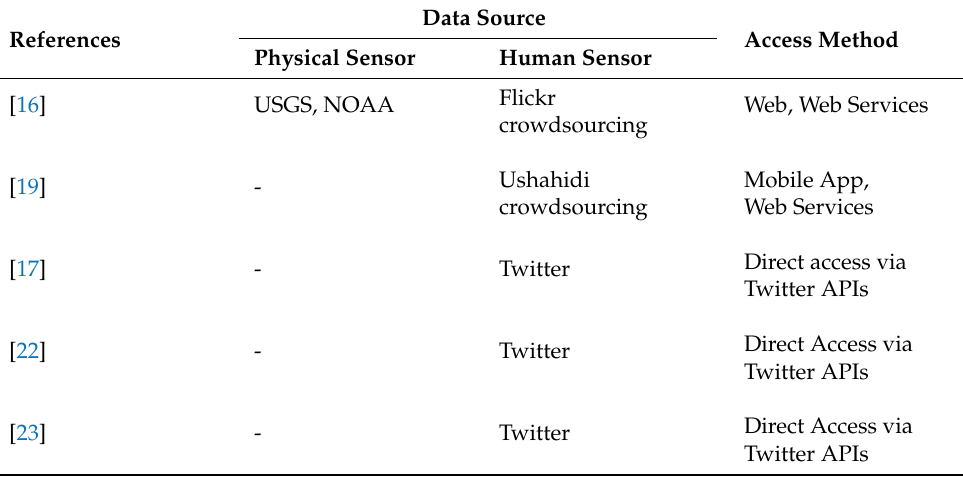
Table 2. Social media for data sources for disaster management.